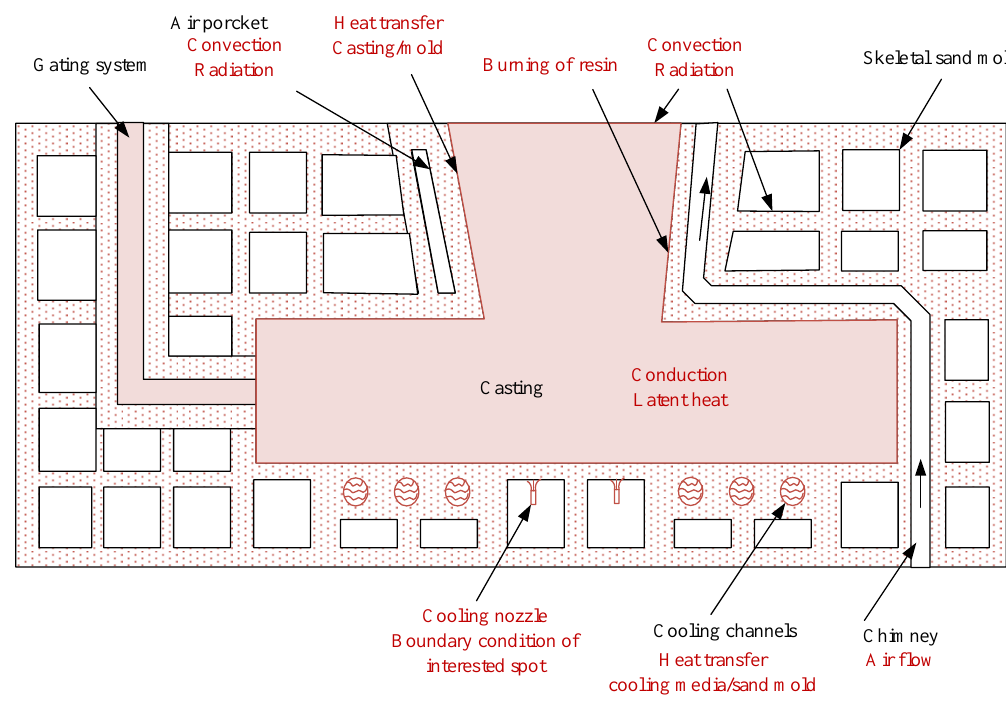
Figure 1. Heat transfer in the casting and skeletal sand mold.